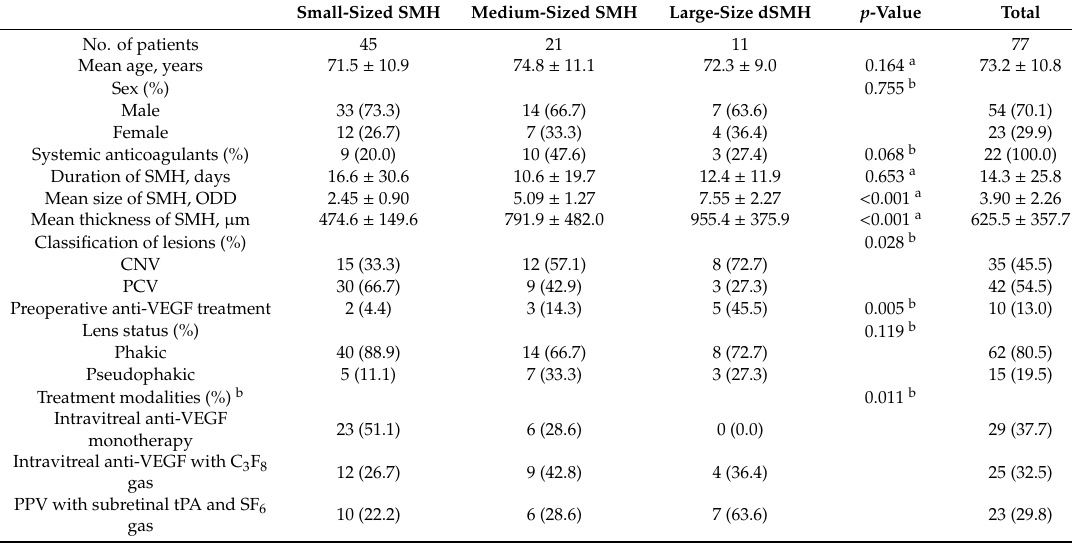
Table 1. Baseline Characteristics.